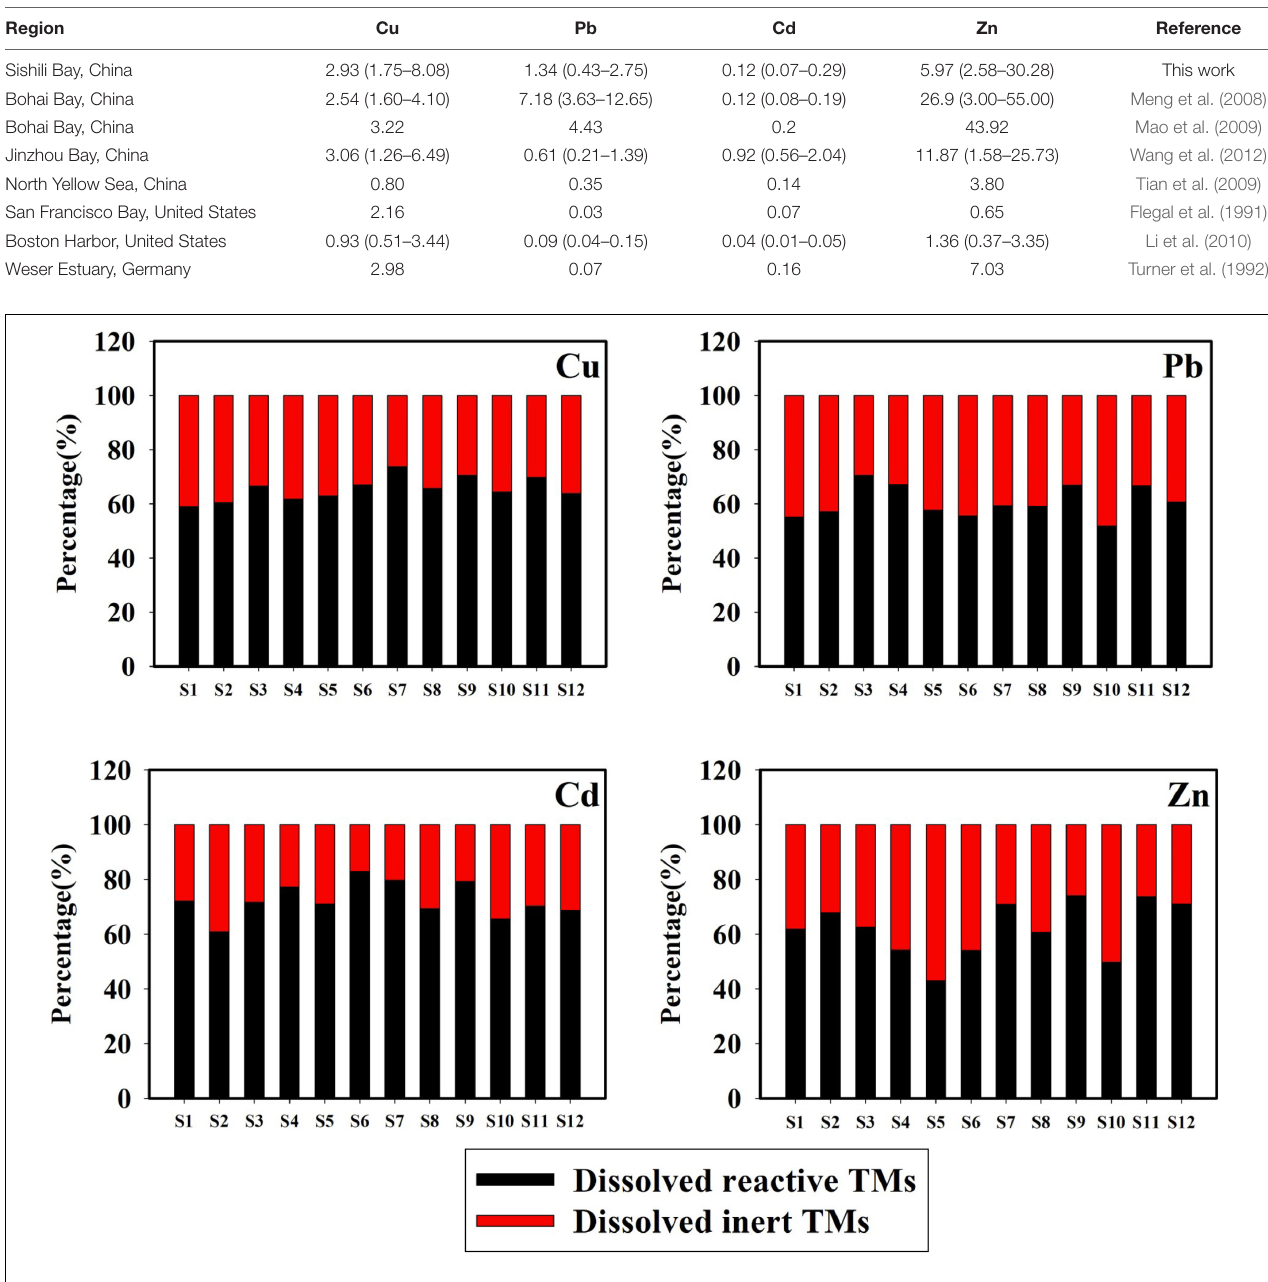
FIGURE 4 | Annual mean percentage of the dissolved reactive and inert concentrations of Cu, Pb, Cd, and Zn in surface seawater of Sishili